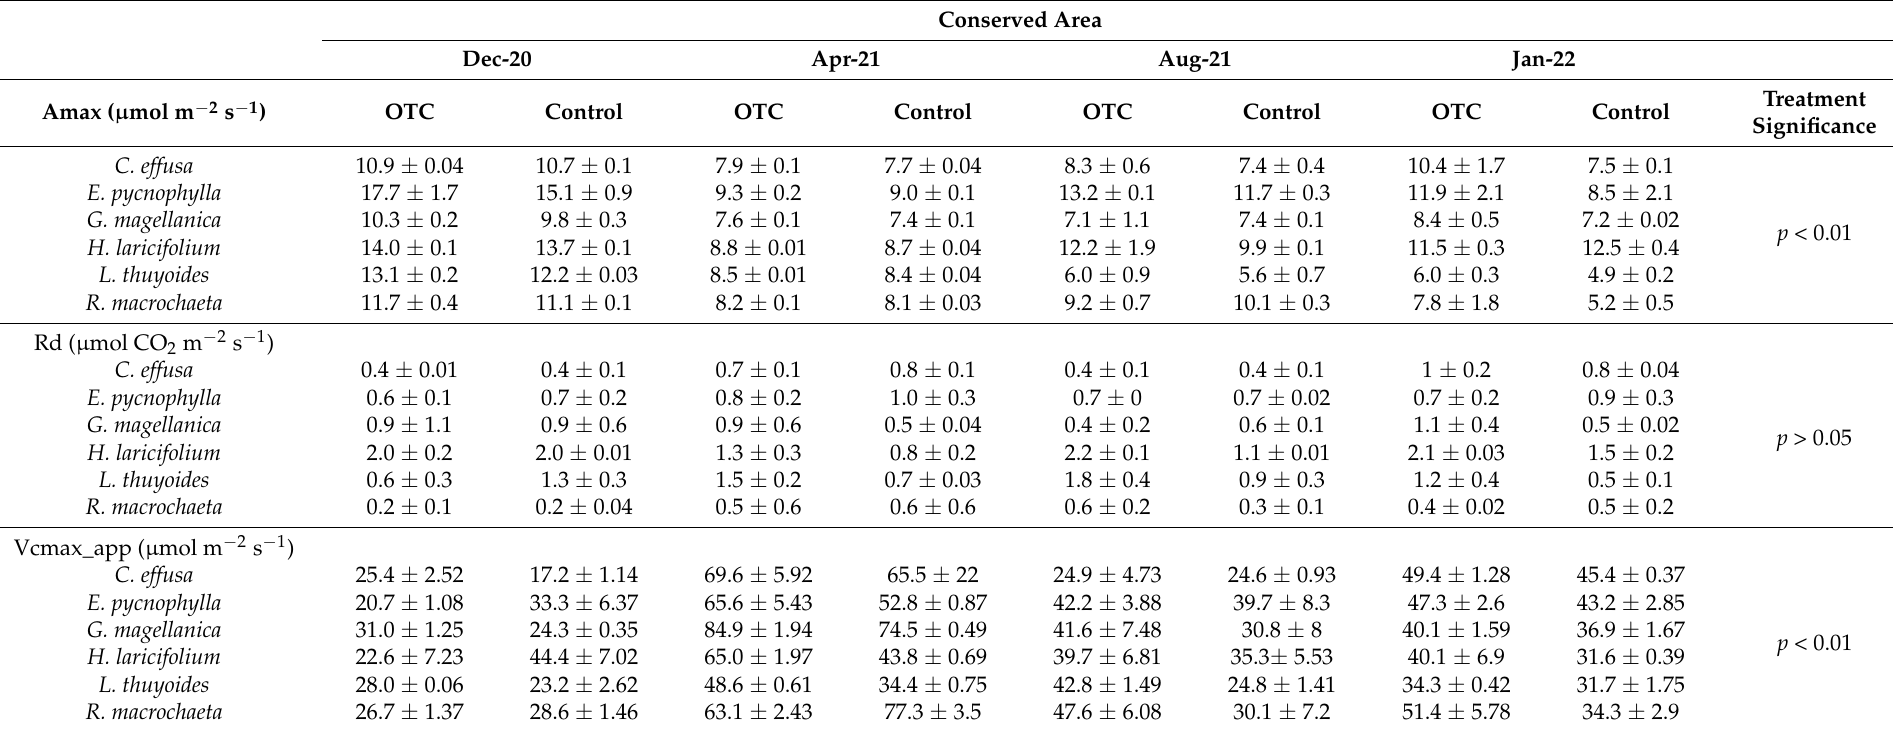
Table 1. Parameters Amax, Rd, and Vcmax_app, derived from the response curves to light and response curves to CO 2 in E. pycnophylla , H. laricifolium , L. thuyoides , R. macrochaeta , C. effusa and, G. magellanica , under conditions of the warming with OTC and control, monitored for one year of the experiment. Values are the sample means ± standard deviation (n =